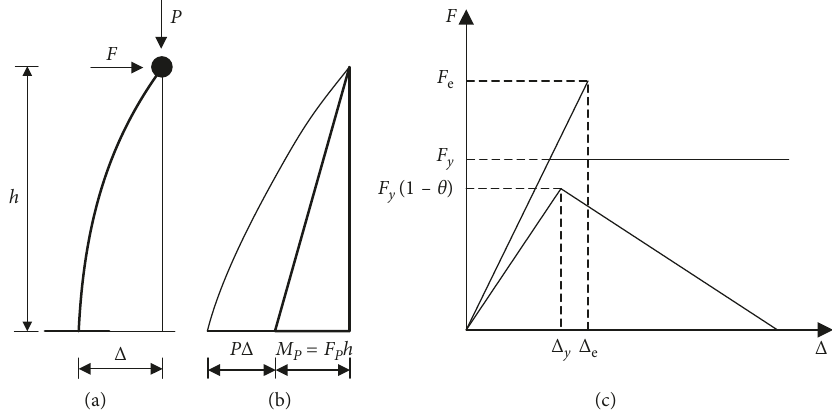
Figure 2: Force-displacement relationships considering P-delta effects.